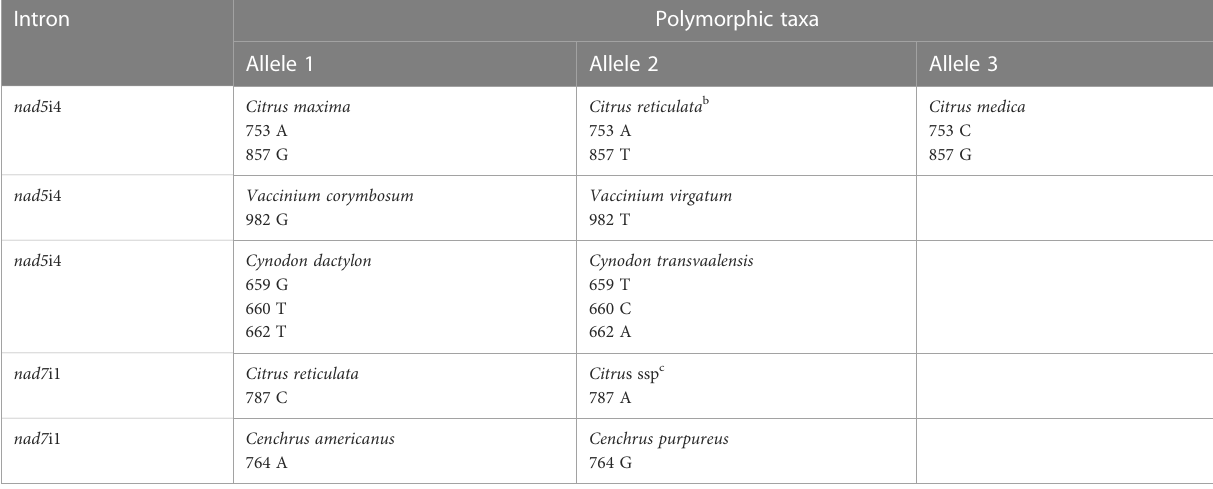
TABLE 6 Intron nucleotide a polymorphisms between congener